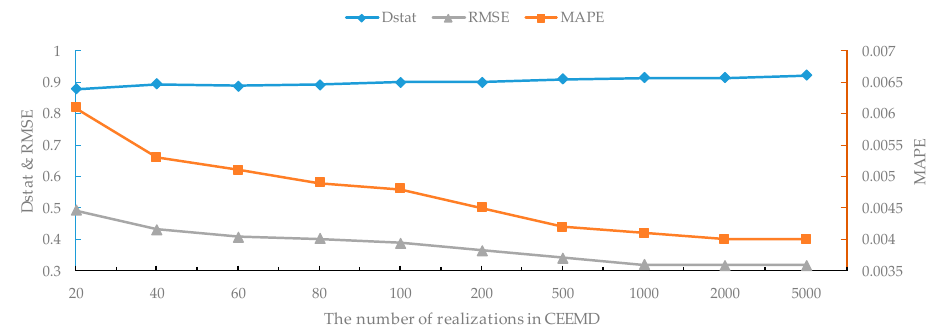
Figure 4. The impact of the noise strength of CEEMD on WTI crude oil prices with one-step-ahead forecasting.